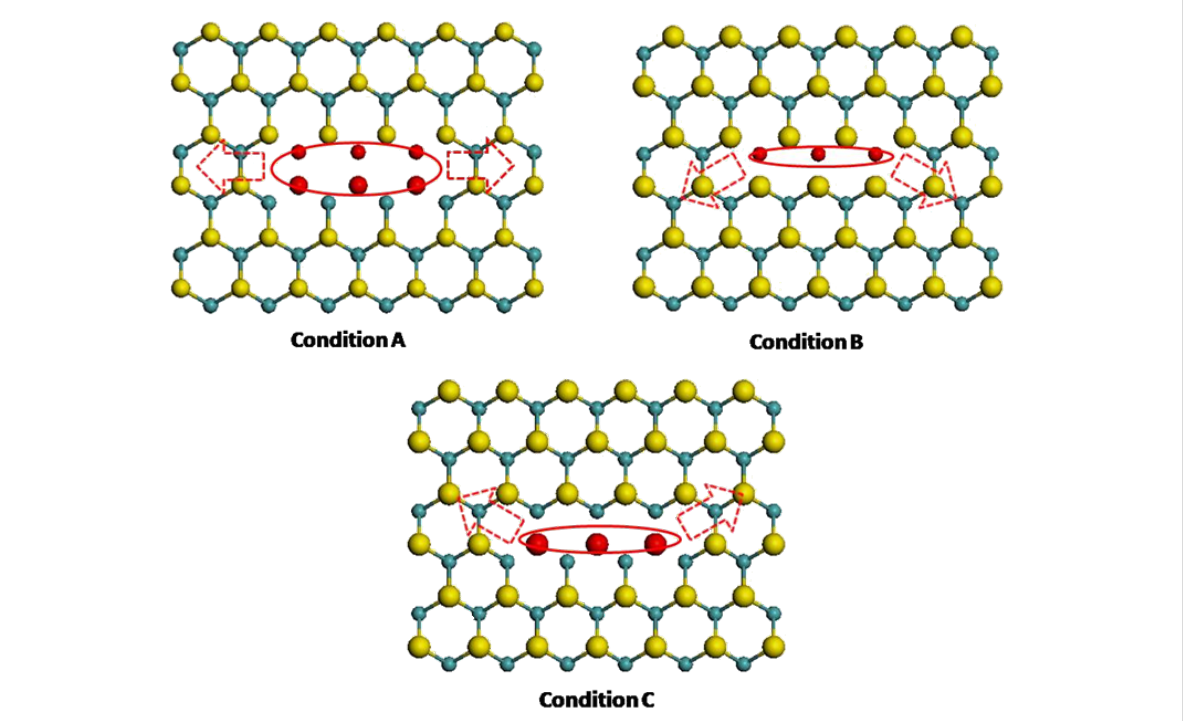
Figure 4: Three types of crack tip configuration with 1nm length: condition A, a Mo atom and two S atoms at the crack tip; condition B, four S atoms at the crack tip; condition C, two Mo atoms at the crack tip.